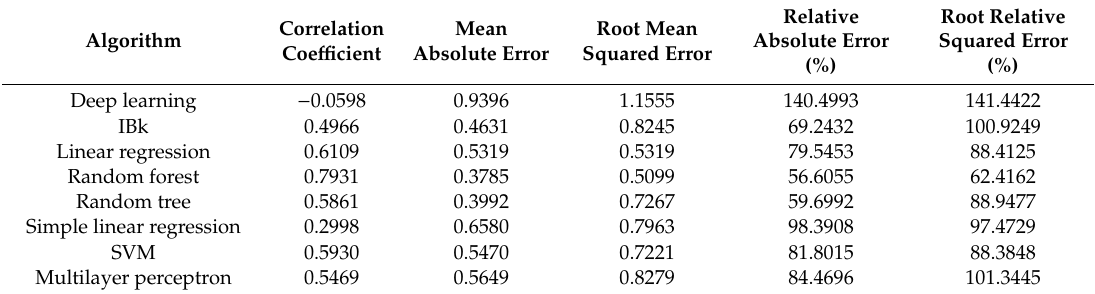
Table 5. Error measures from eight regression algorithms classifying data into four classes.